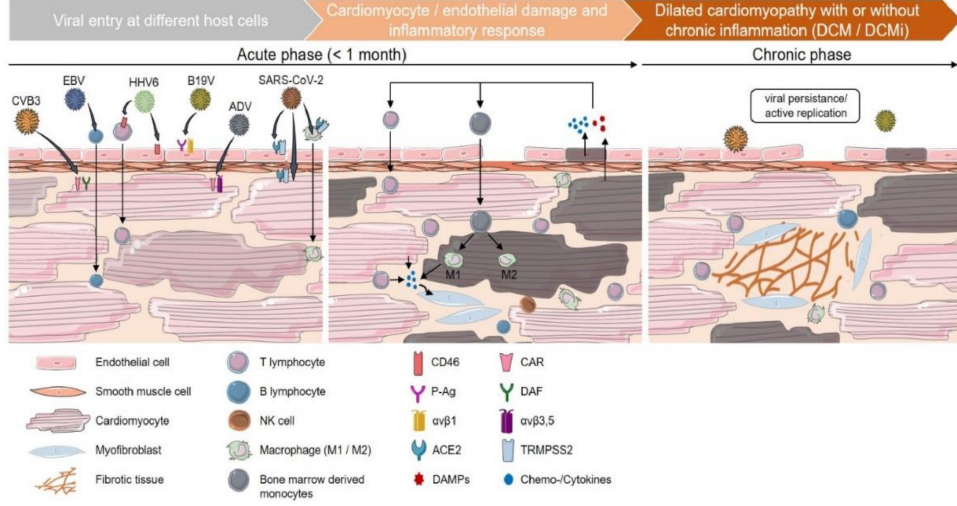
Figure 1. Phases of viral-mediated myocarditis. Cardiotropic viruses enter the myocardium via different host-cellular routes. Coxsackievirus B3 (CVB3) and adenovirus (ADV) directly target cardiomyocytes via the transmembrane coxsackievirus and adenovirus receptor (CAR). The decay- accelerating factor (DAF) serves as an additional CVB3 receptor, whereas integrins ( α v β 3 and α v β 5) act as co-receptors for ADV internalization. Human herpesvirus 6 (HHV6) primarily targets CD4 + t lymphocytes and endothelial cells using CD46 as a cellular receptor. Epstein–Barr virus (EBV) enters cardiac tissue by infection of resting human b lymphocytes and subsequent infiltration into adjacent tissue. Parvovirus B19 (B19V) infects endothelial cells using erythrocyte P antigen (P-Ag) and integrin α v β 1 as a co-receptor. For SARS-CoV-2, several cardiac targets, such as cardiomyocytes, endothelial cells and circulating macrophages, are suggested. Its cellular entry depends on the expression of angiotensin-converting enzyme 2 (ACE2) and transmembrane protease serine subtype 2 (TMPRSS2) on the host-cell surface. Internalization of viral particles triggers a broad spectrum of host-cell responses and the activation of the innate immune system. Direct cardiomyocytolysis or apoptosis is induced by active viral replication and its transcription products (CVB3 and ADV). Indirectly, cardiomyocyte impairment can arise as a consequence of vascular endothelial dysfunction (B19V, HHV6). In addition, myocarditis is suggested to be induced by infected immune cells carrying viral genomes into the myocardium (HHV6, EBV). As a result of cardiac damage, inflammatory cytokines, as well as damage-associated molecular patterns (DAMPs), are released, triggering the infiltration of mononuclear cells, such as lymphocytes and monocytes, which differentiate into M1 or M2 macrophages depending on the inflammatory milieu. The further release of proinflammatory chemo and cytokines leads to the activation of heart-resident myofibroblasts and an increased generation of fibrous tissue. In the case of viral persistence, viral myocarditis can contribute to the chronic deterioration of cardiac function and the clinical presentation of dilated cardiomyopathy